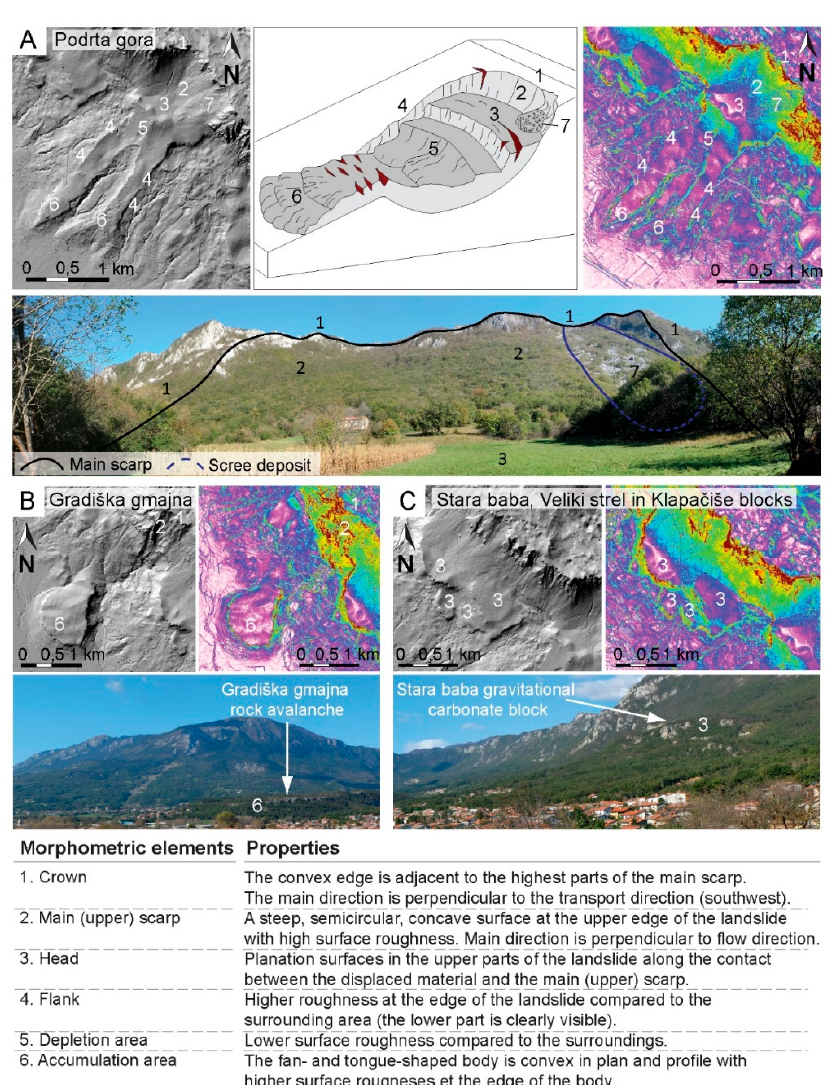
Figure 4. Geomorphometric elements of sedimentary bodies: ( A ) Podrta gora fossil rock avalanche; ( B ) Gradiška gmajna fossil rock avalanche; and ( C ) Stara baba, Veliki strel, and Klapaˇciše carbonate blocks, based on the classification of the schematic representation of the landslide. Adapted from